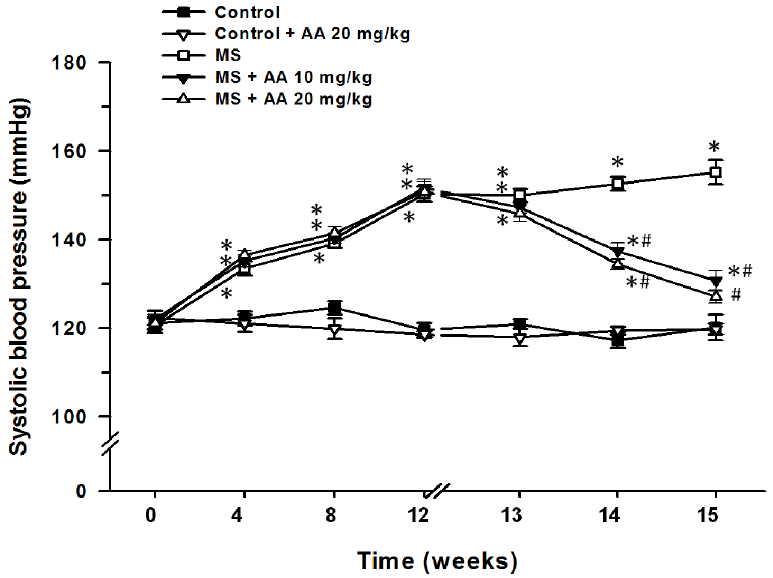
Figure 2. Effect of asiatic acid on systolic blood pressure in all experimental groups. Results are expressed as mean ± SEM. AA represents asiatic acid. * p < 0.05 vs . control group, # p < 0.05 vs . MS group ( n = 8/group).